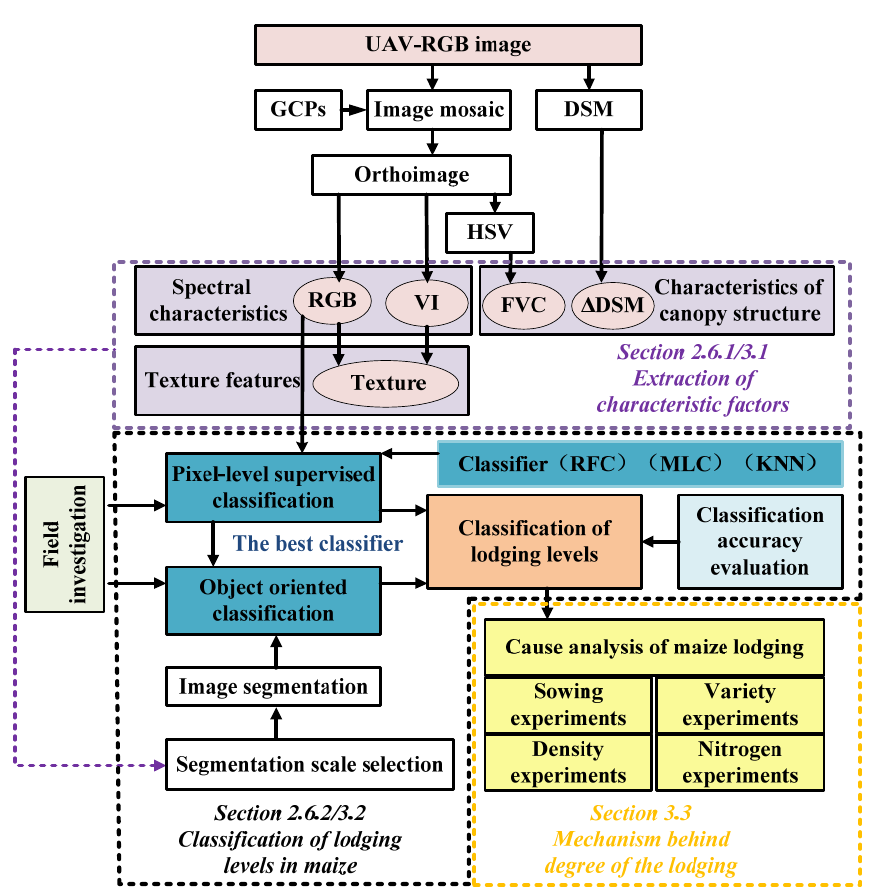
Figure 4. Classification of maize lodging and process for analyzing the cause of lodging.